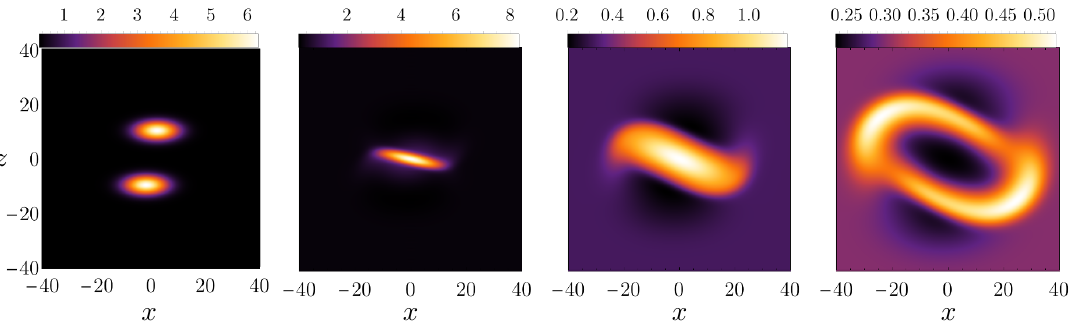
Figure 2 . Charge density at the collision plane at t = (0 , 4 , 9 , 15) for the charged background collision from table